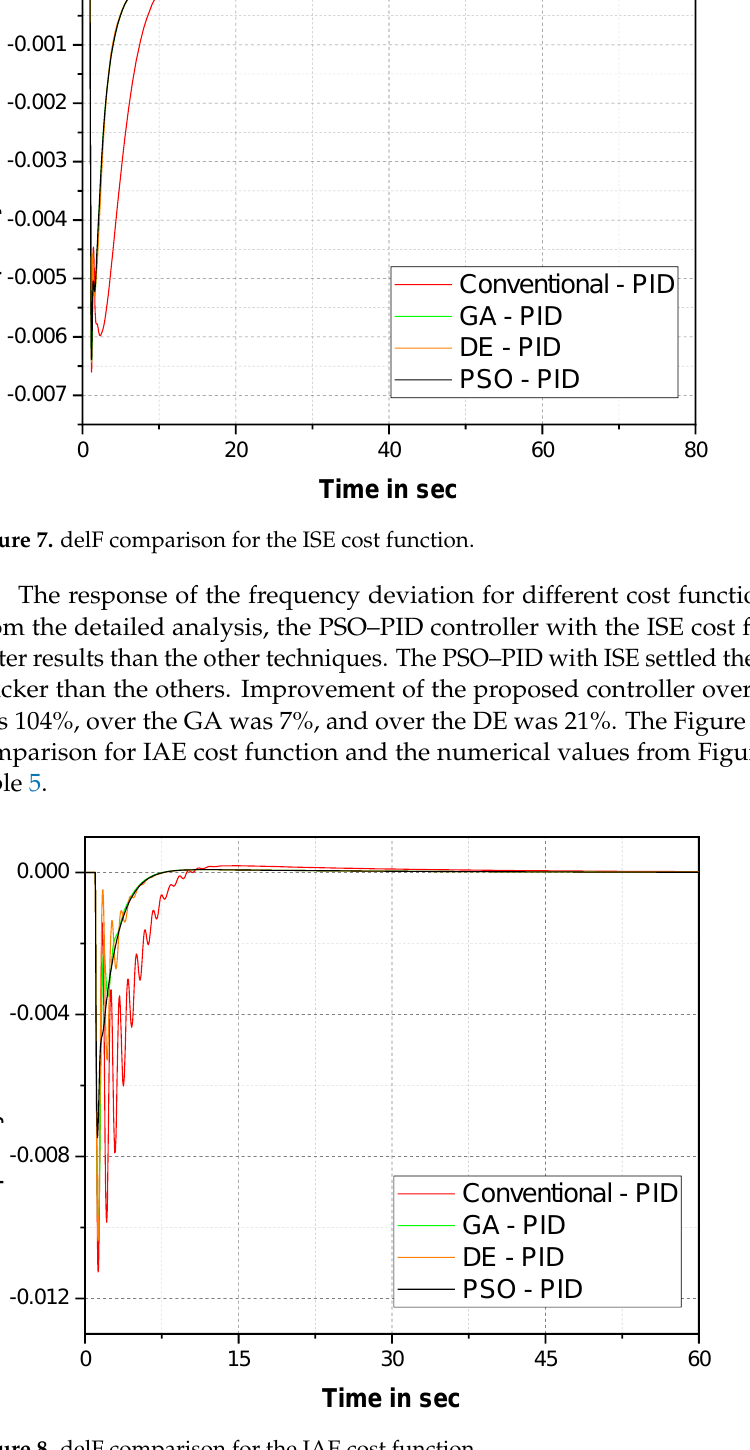
Figure 8. delF comparison for the IAE cost function. Table 5. Controlled parameters of delF using the IAE cost function.